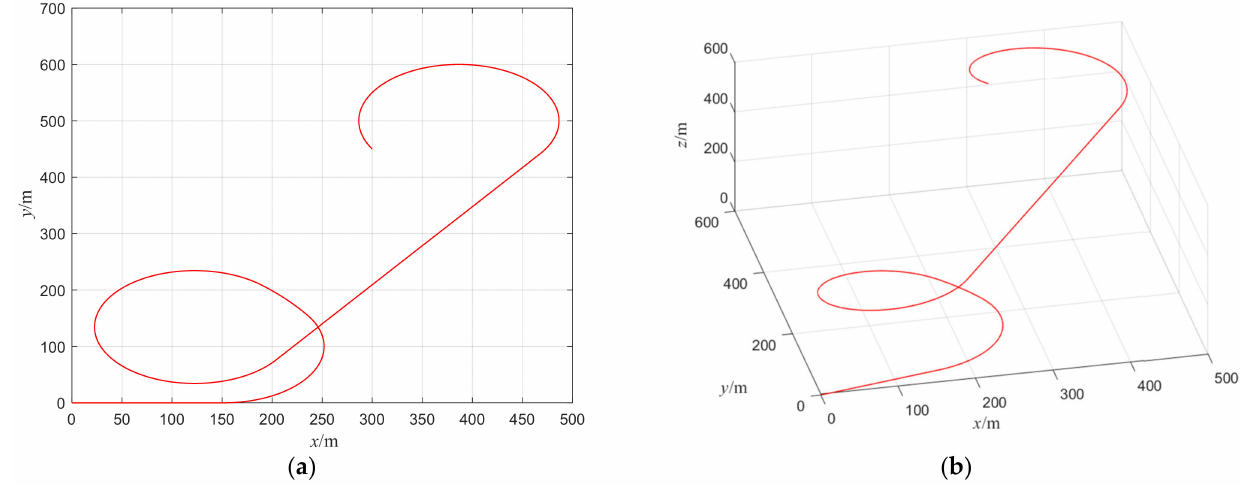
Figure 4. Multiphase homing trajectory planning results: ( a ) plane trajectory; ( b ) 3D trajectory.